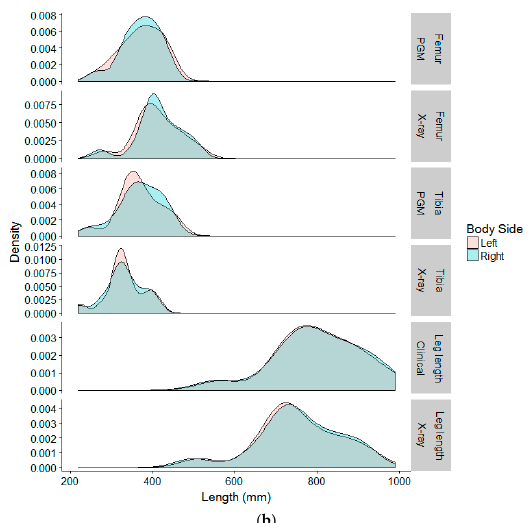
Figure 1. ( a ) Symmetricity of 15 participants for all lower limb measurements in both methods. Patient ID 1–10 children, 11–15 adults; ( b ) Density plot comparing distribution between sides for each measurement. PGM: Plug-in-Gait-model.